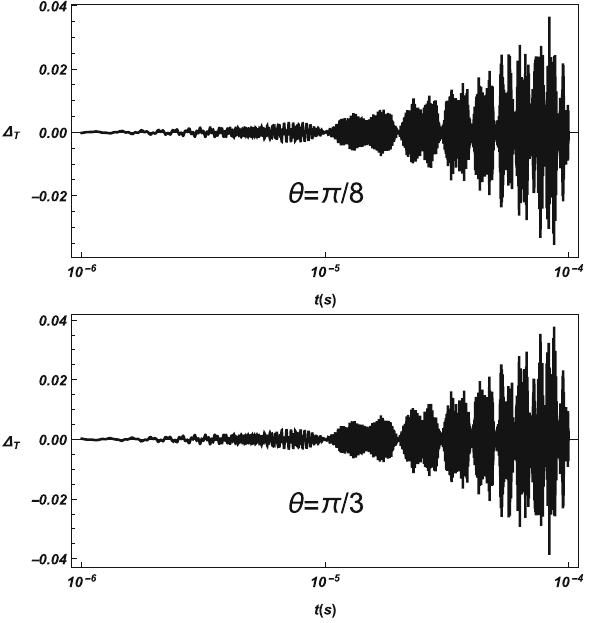
Fig. 6 Plots of (cid:14) T ( t ) for different choices of θ for a set-up with n = 6 trappedions.ThesameparametersasFig.5areused.Weusedadifferent timescale to better highlight the T -violation